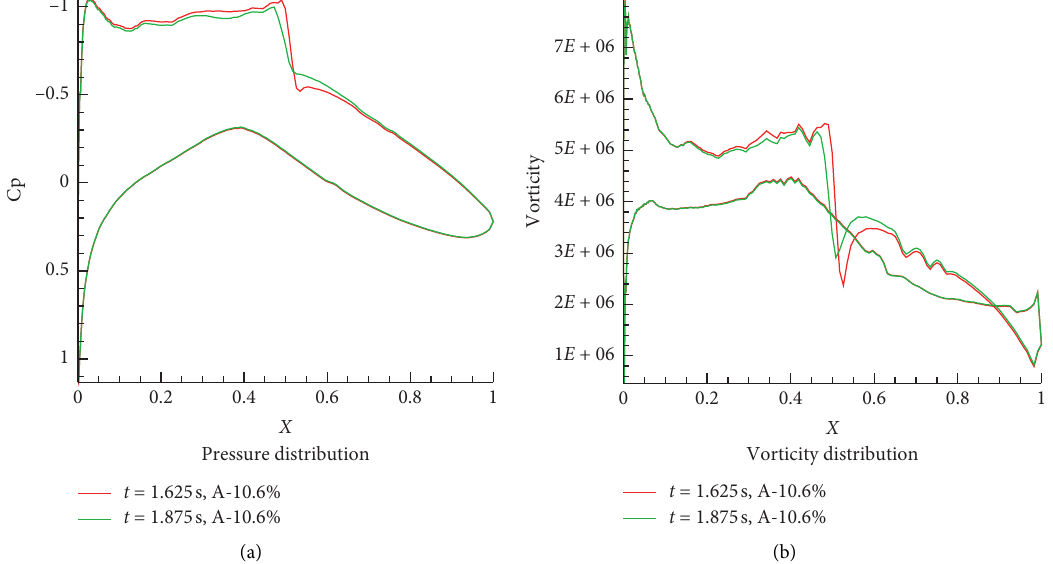
Figure 10: Pressure and vortex distribution at the same thickness ( − 10.6%) in one cycle ( M � 0.74 and α � 2 ° , CFD). (a) Pressure distribution. (b) Vorticity